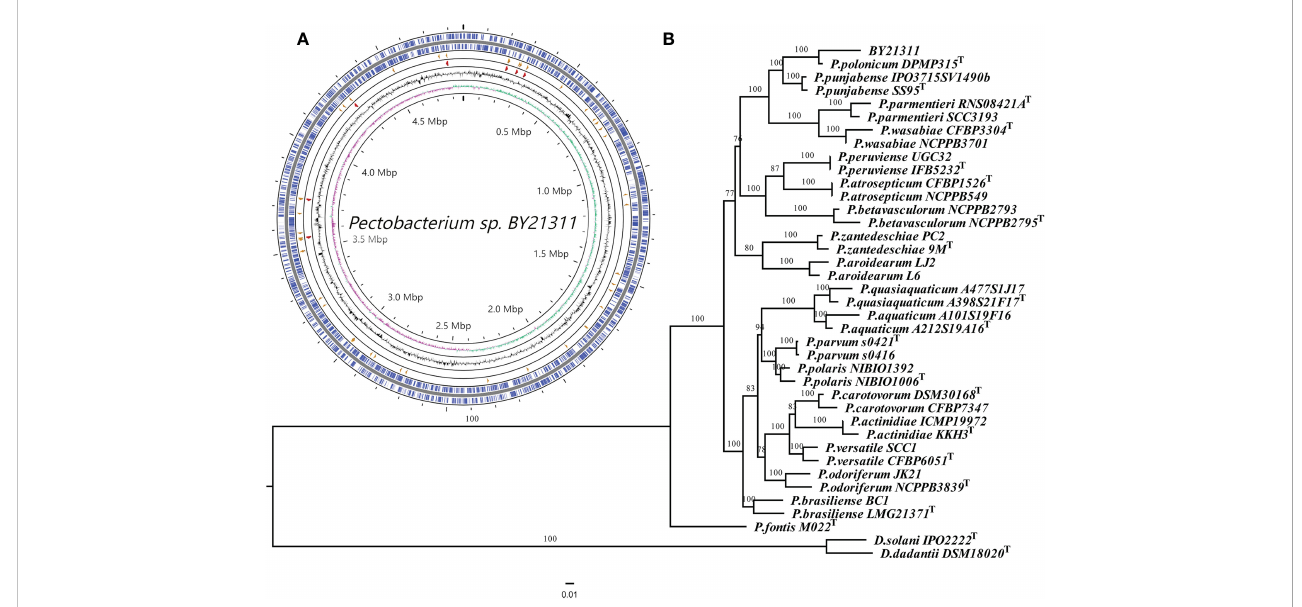
FIGURE 1 Genome map of Pectobacterium isolate BY21311 and genome-based phylogenetic inference. (A) Circular representation of the complete genome assembly of isolate BY21311. The circles represent (from inner to outer) GC skew, GC%, rRNAs, tRNAs, and protein-coding genes on the forward and reverse strands. (B) Maximum likelihood (ML) tree showing the phylogenetic relatedness between isolate BY21311 and other closely related Pectobacterium species, based on the concatenated sequences of 376 conserved genes. Dickeya solani and D. dadantii were selected as outgroup. ML tree was constructed using RAxML v8.2.12 with ‘ PROTGAMMAJTTF ’ setting. The superscript ‘ T ’ in the tree indicates type strain. The branch lengths indicate the evolutionary distance as the number of amino acid substitutions per site. The numbers shown next to the branches indicate the percentage of bootstrap support values (1000 replicates).